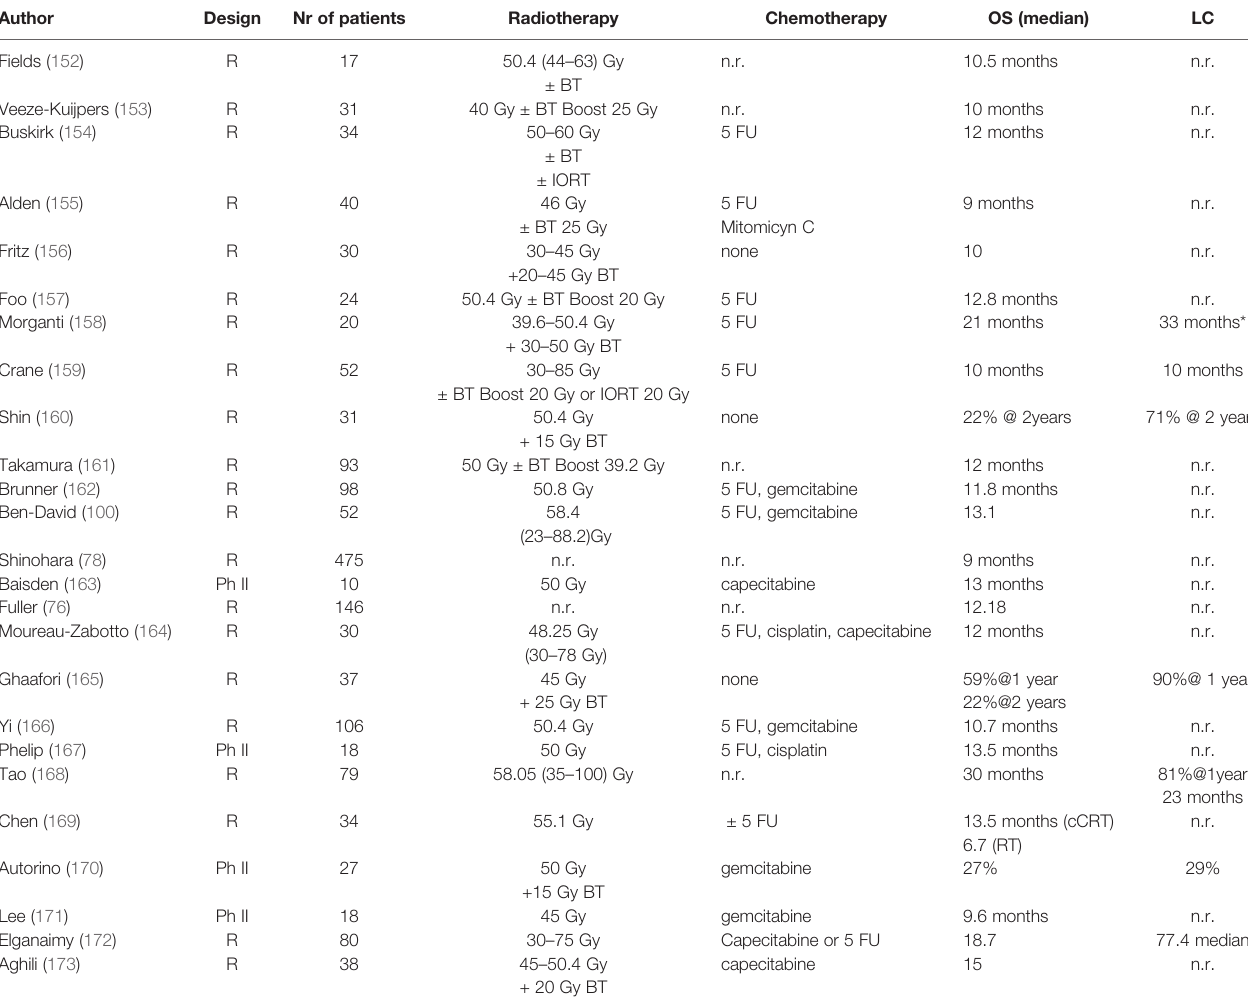
TABLE 5 | Radiotherapy in inoperable